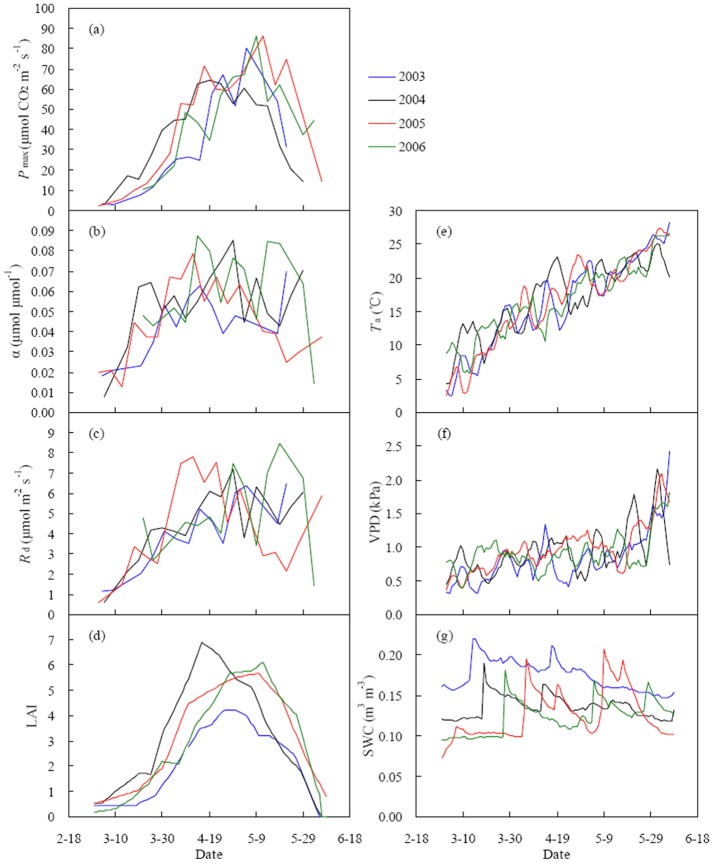
Seasonal variation of initial light use efficiency (α), maximum photosynthetic capacity (P
max), daytime ecosystem respiration under dark conditions (R
d), air temperature (T
a), vapor pressure deficit (VPD) and leaf area index (LAI) in a winter wheat field during the main growing season.α, P
max and R
d were obtained at 5-day intervals using a regression model (Eq. (3)).